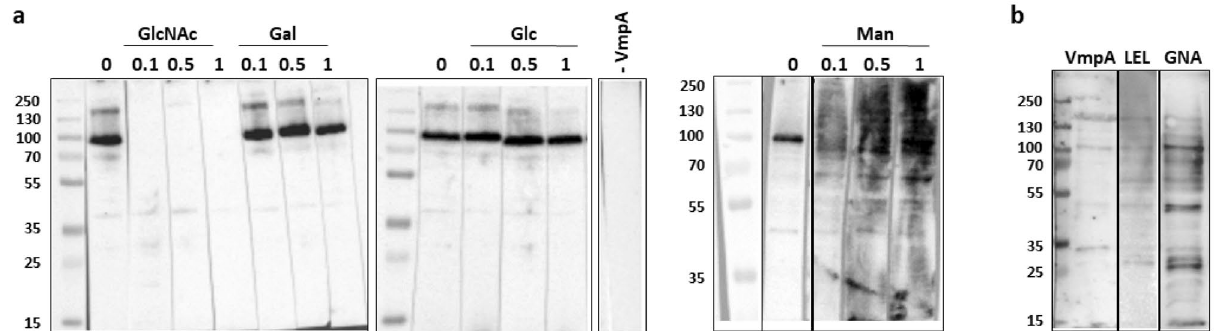
Figure 7. Interaction of VmpA-His 6 with insect proteins. The results are presented from different blots (full length) framed by black lines. ( a ) Euva-6 proteins from culture passage 7 transferred to nitrocellulose membranes were incubated with recombinant VmpA-His 6 alone (lane 0) or in the presence of 0.1 to 1 M Gal, Glc, GlcNAc or Man. The presence of VmpA-His 6 interacting with insect cells was detected using anti-VmpA antibodies. ( b ) Euva-6 proteins from culture passage 32 transferred to nitrocellulose membranes were incubated with recombinant VmpA-His 6 or the lectins LEL and